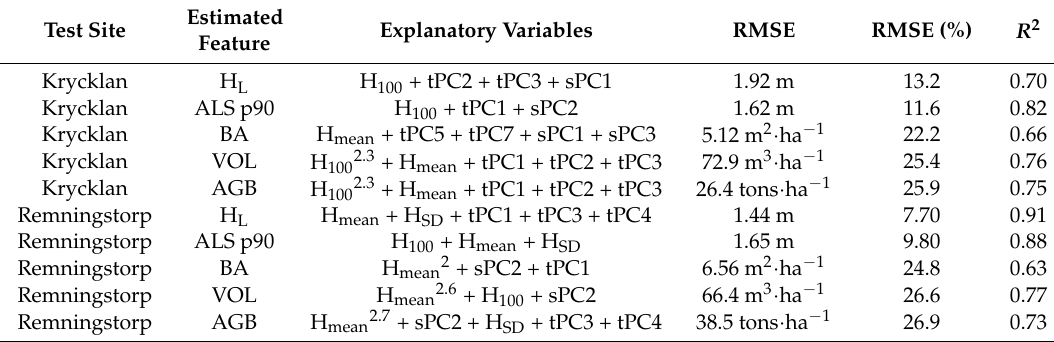
Table 7. Results estimated from height metrics, spectral (s), and textural (t) principal components (PCs). The abbreviations have the same meaning as